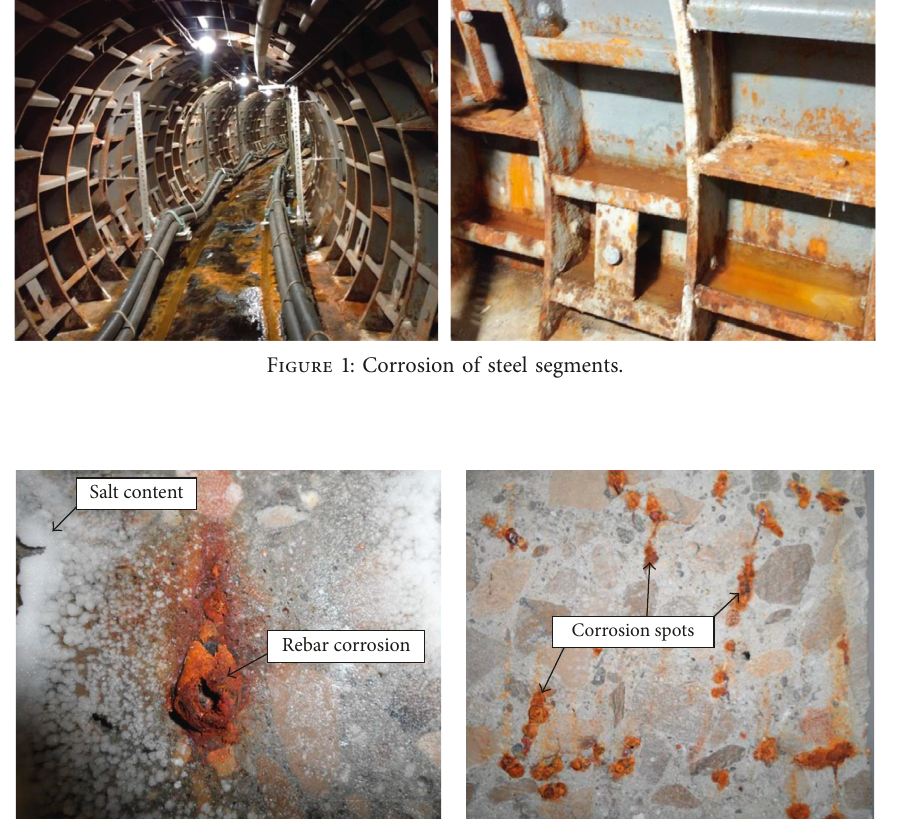
solution. (a) RC beam specimen. (b) SFRC beam −